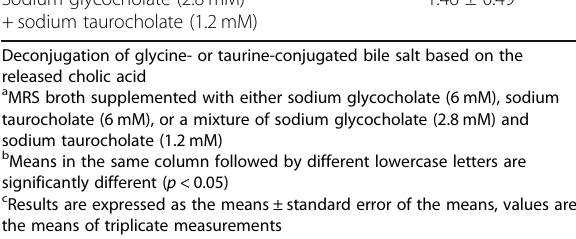
the means of triplicate